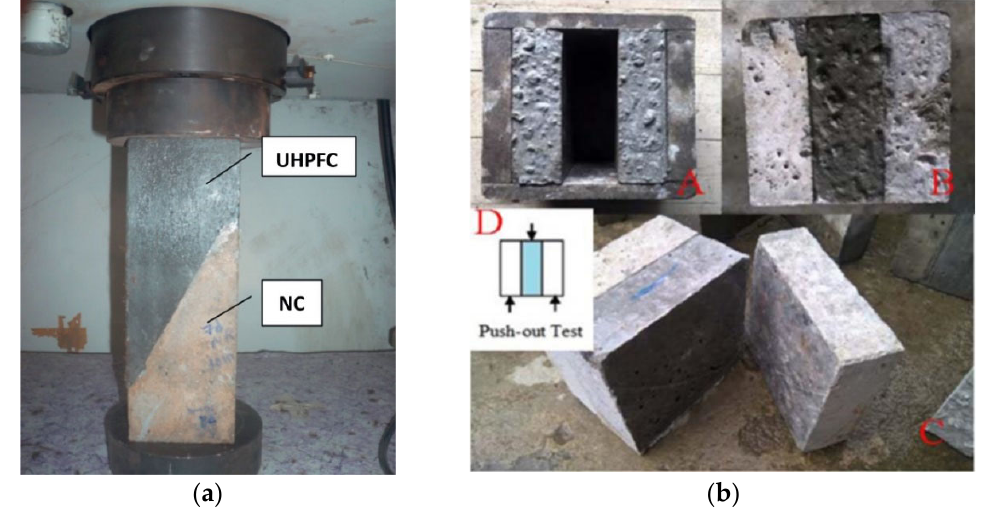
Figure 3. Tests for shear bond strength between repair materials and concrete substrate. ( a ) slant shear test set ‐ up for the composite specimen; ( b ) push ‐ out test for the composite specimen (A, B: preparation of samples; C: the damage mode; D: Schematic diagram of load force) [58]. (Adapted and reprinted with permission from ref. 58, © 2012, Construction and Building Materials .).